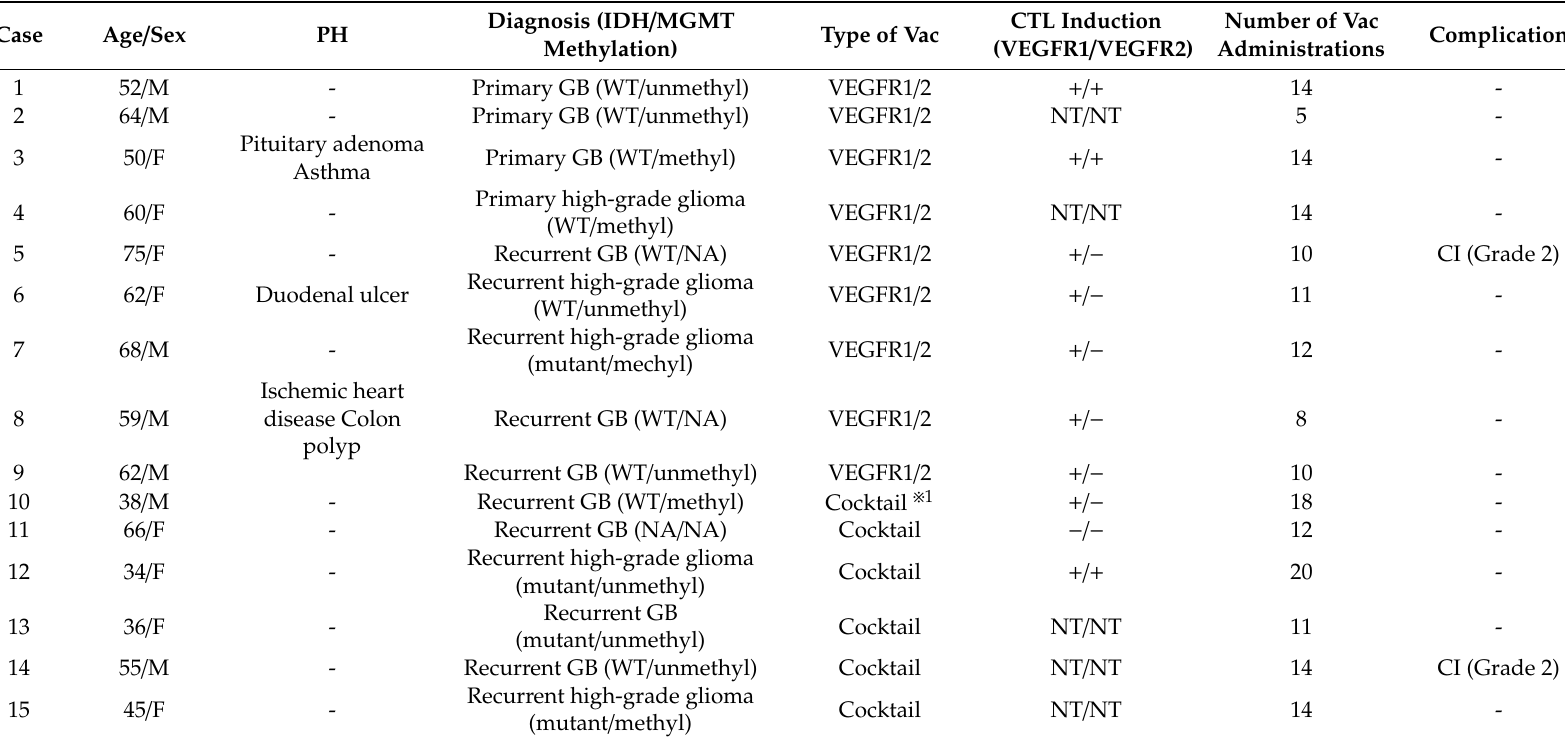
Table 3. Adverse event profile of patients after VEGFRs peptide vaccination without Bev (Vac